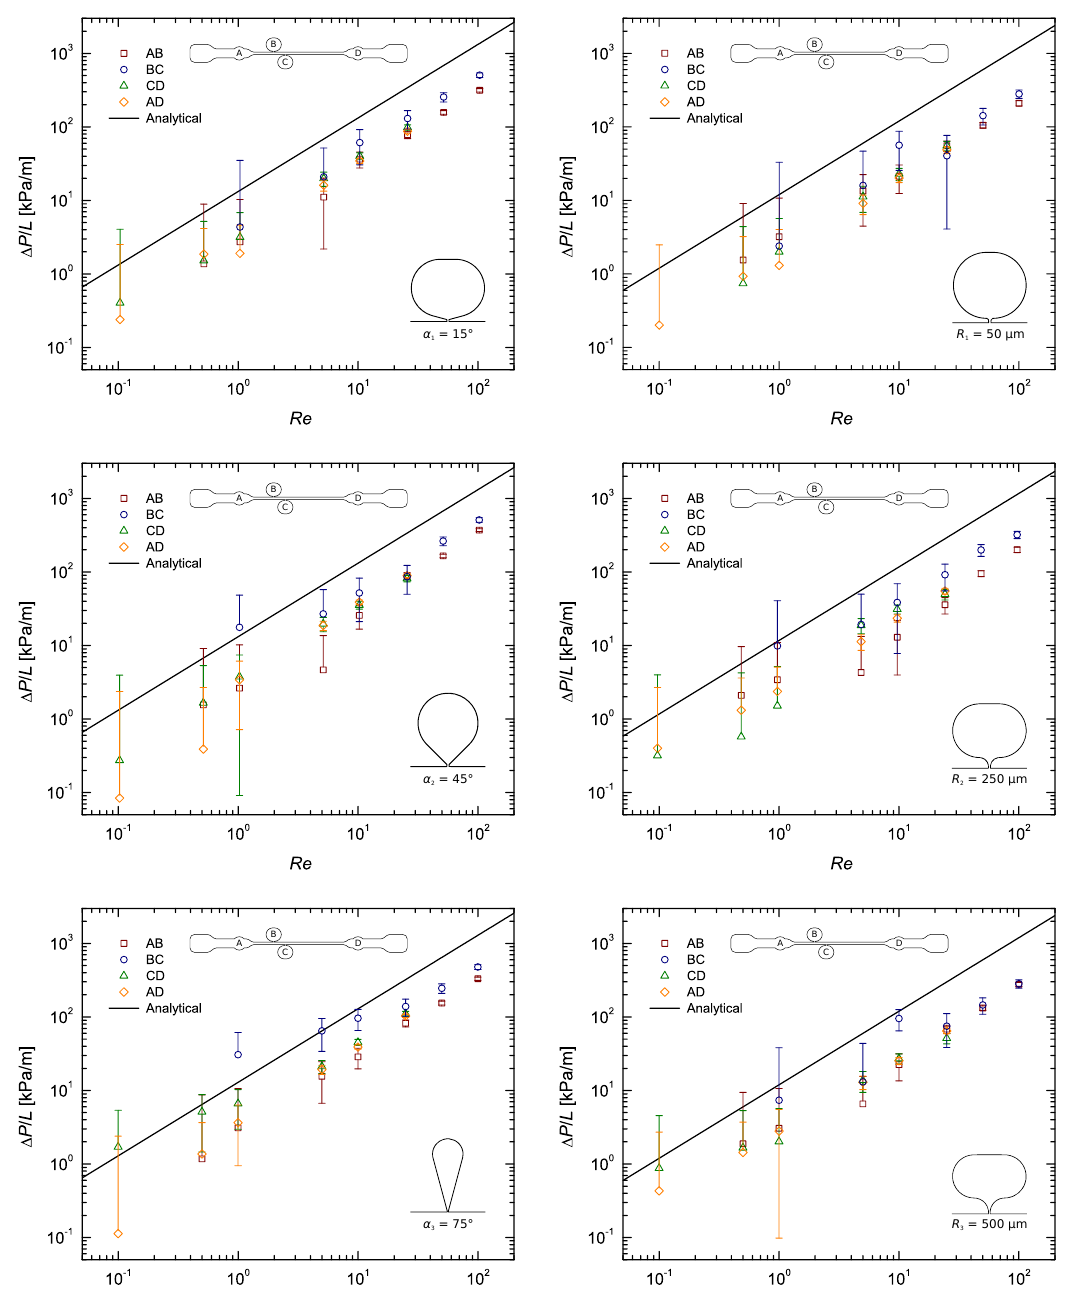
Figure A2. Pressure gradient as a function of the Reynolds number for the flow of DI water along a rectangular microchannel: Pressure taps with sub-channel width w 1 = 54 µ m; α taps on the left and R taps on the